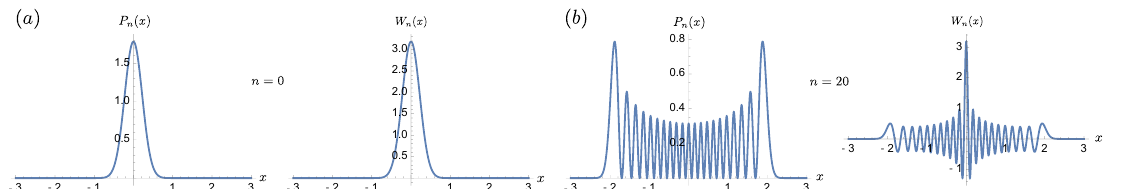
oscillatory and the number of nodes is equal to n , but into the classically forbidden region, the probability exponentially decays, as shown in Figure 2.